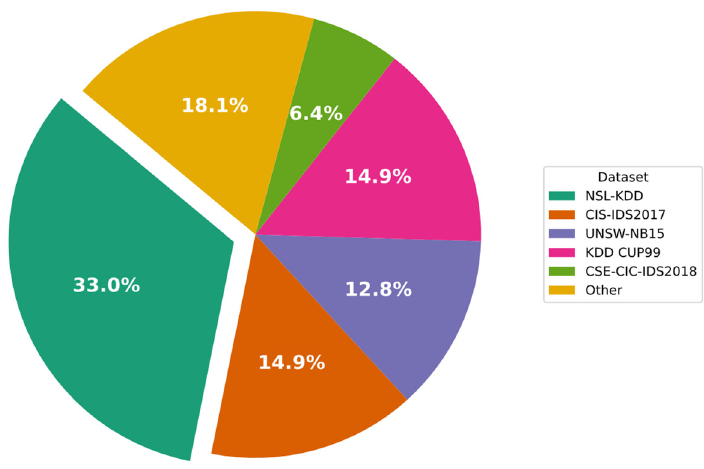
Figure 6. Percentages of datasets applied in CNN-IDS solutions.